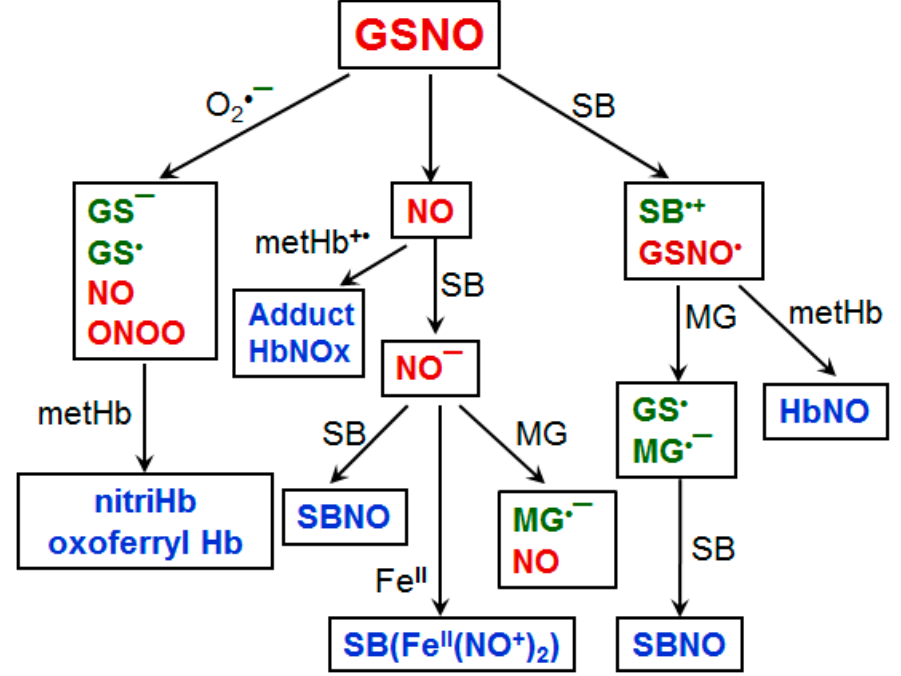
Figure 5. A set of products and free-radical intermediates formed in the reaction of S- nitrosoglutathione with MG in the presence of Hb. R-SNO—nitrosothiols (nitrosoglutathione, ni- trosocysteine); SB—Schiff base; SBNO—nitroso adduct of Schiff base; SB(Fe II (NO + ) 2 )—dinitrosyl iron complexes associated with Schiff bases; nitriHb—Hb nitrated at the vinyl group of the por- phyrin ring; metHb—oxidized Hb, metHb •+ —the Hb-bound Schiff base radical cation, oxofer- rylHb—Hb-Fe IV =